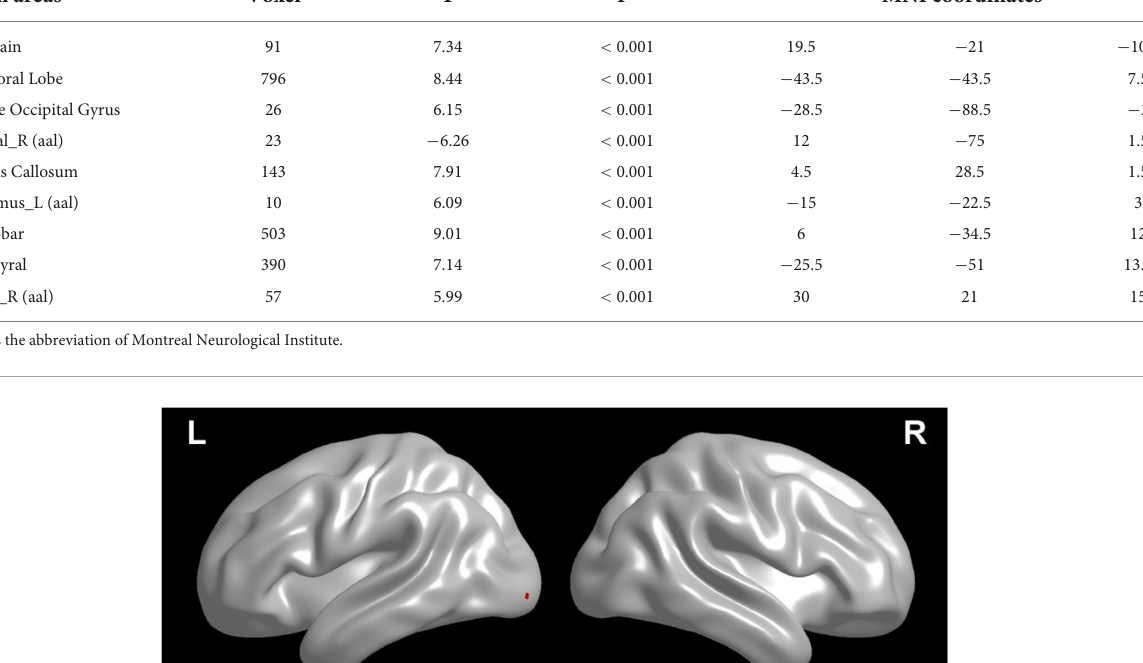
TABLE 3 Differences in brain white matter among participants in the rehydration state in test 3 and participants in the dehydration state in test 2. Brain areas